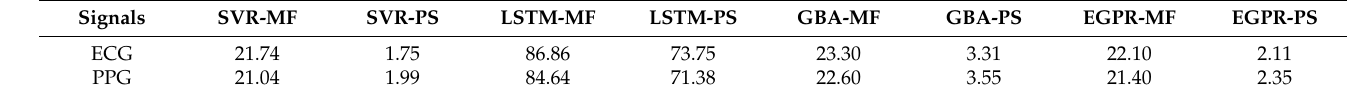
Table 2. We compare feature extraction, training, and testing times between the traditional and